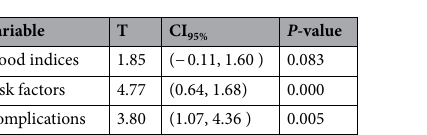
Table 2. The Multivariate meta-regression analysis. CI confidence